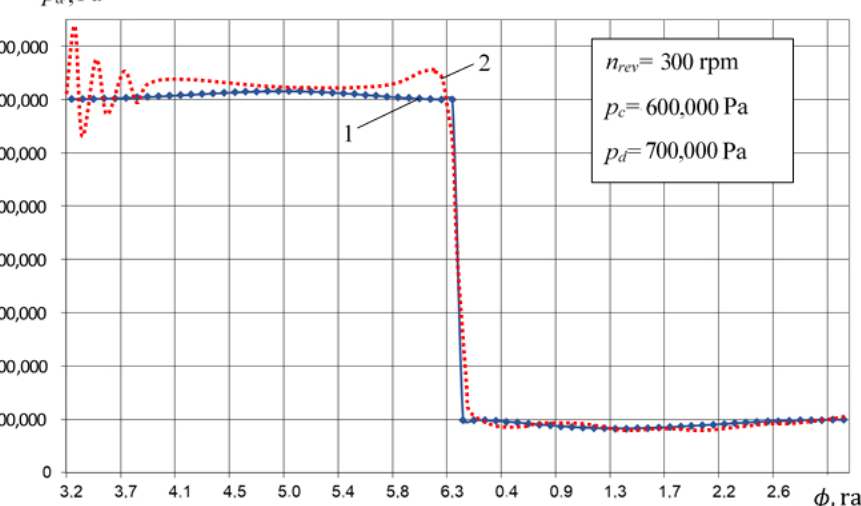
Figure 11. Dependence of the instantaneous pressure in the pump section in a crosshead-free PHPM determined experi- mentally and by calculation (1—Calculation; 2—Experiment).